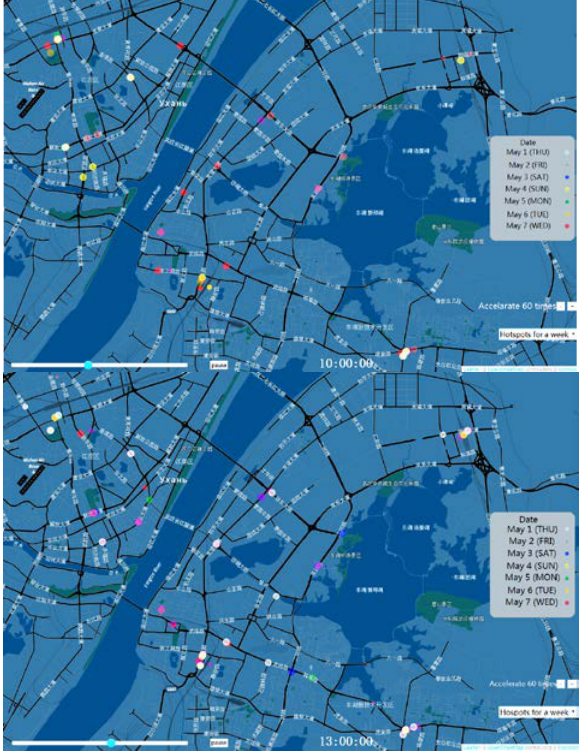
Figure 13. Hotspots for pickup sites at different time for a